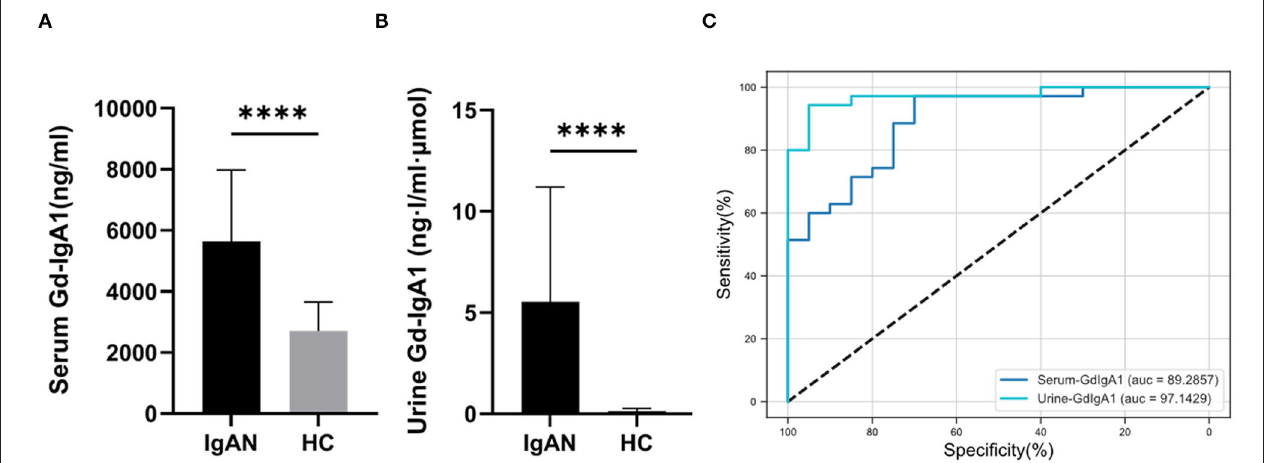
FIGURE 1 | Serum and urine Gd-IgA1 levels. The level of serum (A) and urine (B) Gd-IgA1 levels were significantly higher in patients with IgAN compared to healthy and disease controls (**** P < 0.0001). (C) ROC curve of the serum and urine levels of Gd-IgA1 in the exploration cohort with P < 0.05.